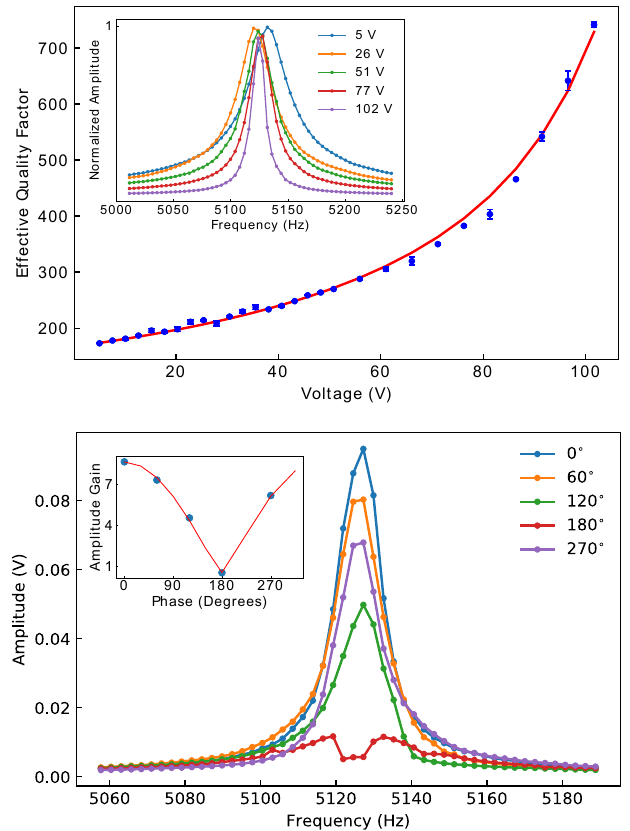
Figure 3. Top : Effective quality-factor Q ef f as a function of parametric excitation. The solid red line is a fit to Equation (3). The inset shows examples or resonance peaks at different voltages. The amplitude of the peaks was normalized by the fitted corresponding amplitude of each peak. Bottom : Resonance peaks as the phase of the parametric signal was varied while the parametric excitation voltage was kept at 102 V. The inset shows the amplitude gain as a function of phase. The red line was fitted from Equation